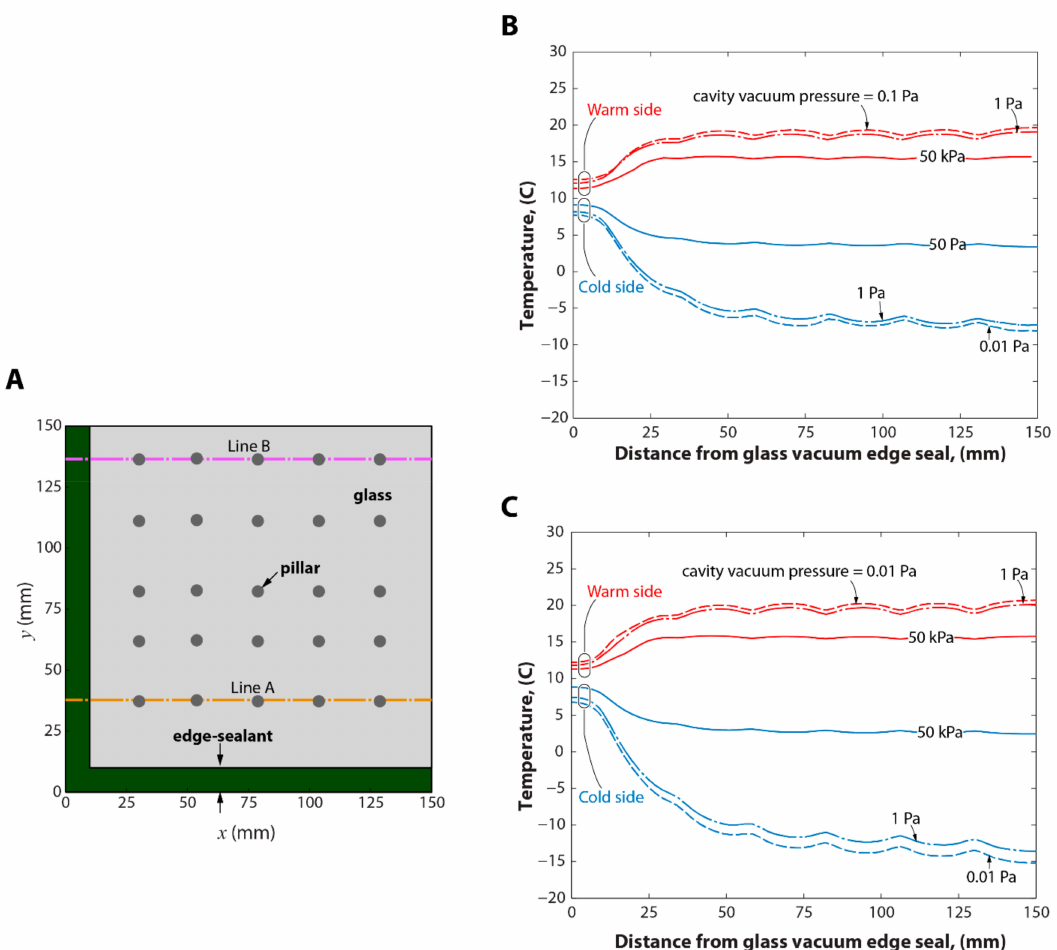
Figure 7. ( A ) The surface temperature contours for the hot and cold sides at the cavity pressures of 0.001 Pa, 1 Pa, and 50 kPa, spreading from the vacuum edge seal to the centre-of-pane of one-quarter of the TVG ( B ) along Line A and ( C ) Line